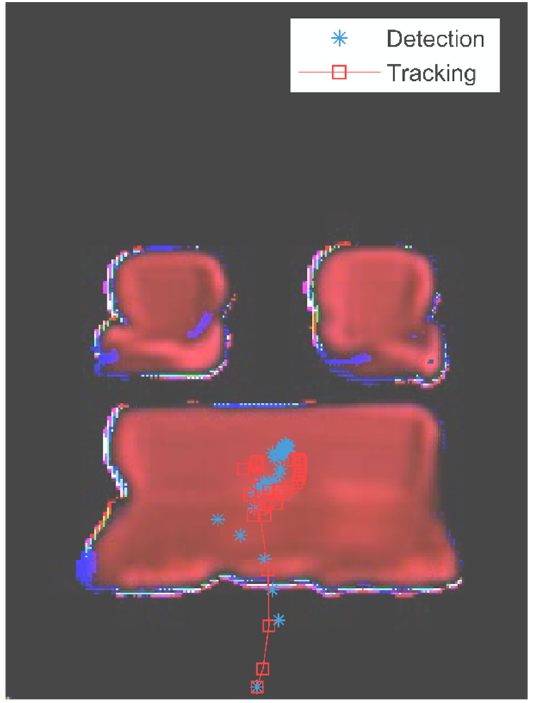
Figure 9. The tracking result of the back seat part.